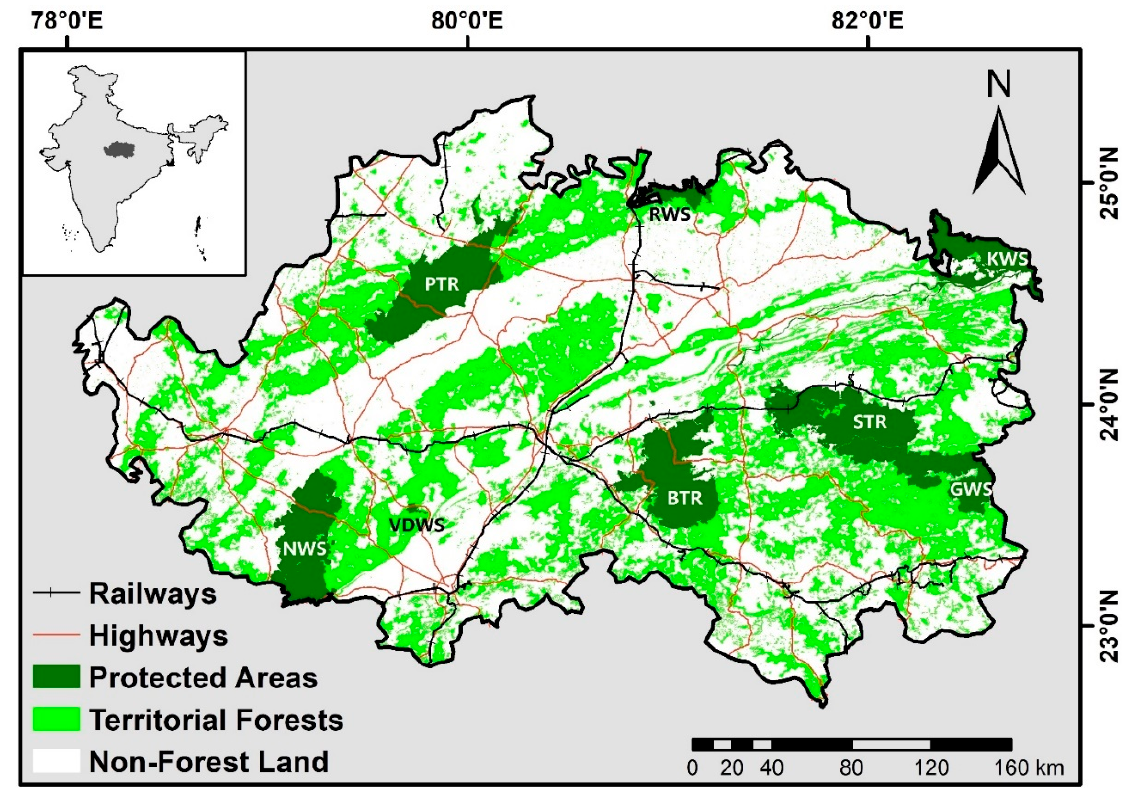
Figure 1. The study landscape comprising eight protected area units (tiger reserves, national parks, and wildlife sanctuaries), multiple-use forests (territorial forests), and non-forest land (agricultural fields, villages, and urban centers). PTR: Panna tiger reserve, NWS: Nauradehi wildlife sanctuary, VDWS: Veerangana Durgavati wildlife sanctuary, BTR: Bandhavgarh tiger reserve, STR: Sanjay Dubri tiger reserve, GWS: Guru Ghasidas wildlife sanctuary, KWS: Kaimur wildlife sanctuary, RWS: Ranipur wildlife sanctuary.